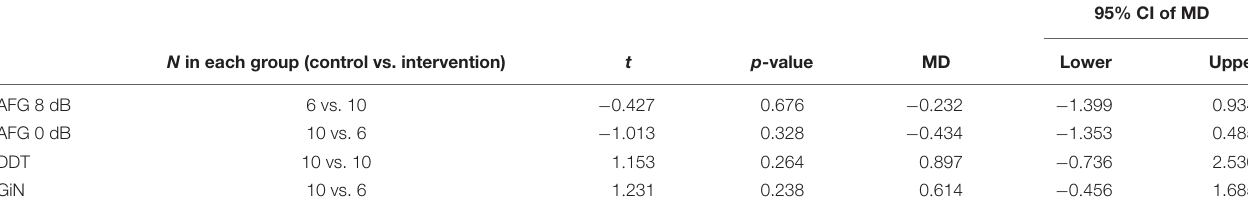
TABLE 9 | Results of the independent samples t -tests comparing the mean differences between the control and intervention group in the AFG 8 dB, AFG 0 dB, DDT, and GiN tests.